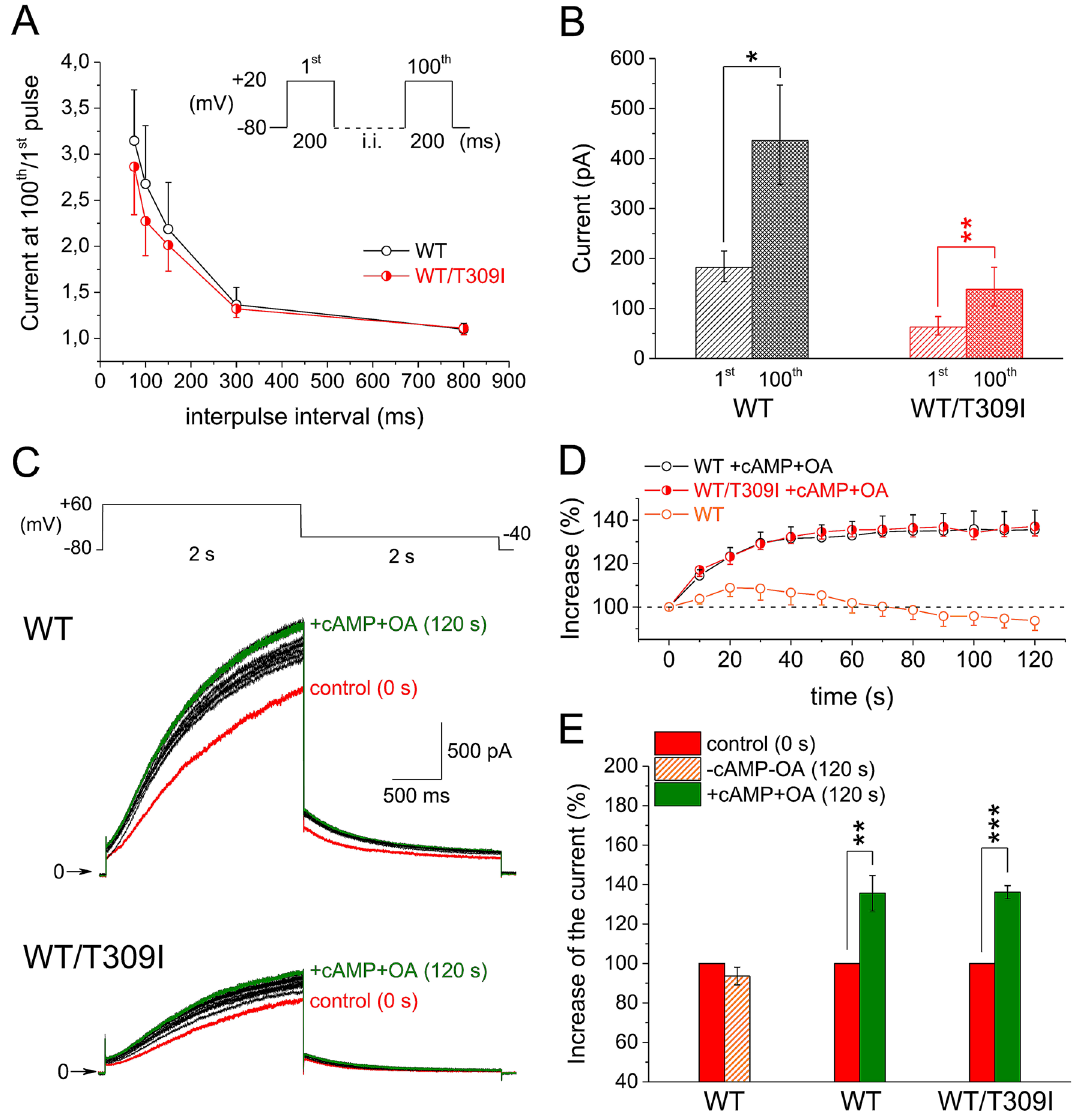
Figure 3. Accumulation of WT and WT/T309I currents (KCNE1 subunit cotransfected). ( A ) Average relative rate-dependent accumulation of the currents at interpulse intervals between 75 and 800 ms ( n = 10 and 8 in WT and WT/T309I channels, respectively); inset: experimental protocol applied after a 30-s pause; i.i.—interpulse interval. ( B ) Average absolute currents at the 1st and 100th pulse of the accumulation protocol with the interpulse interval of 100 ms. ( C ) Experimental protocol (the stimulation frequency 0.1 Hz), and representative traces of WT and WT/T309I currents under simulated β-adrenergic stimulation (cAMP and OA in the pipette solution); red trace—time 0, control (no cAMP/OA stimulation); green trace—time 120 s, steady-state β-adrenergic stimulation; black traces—time 10 to 110 s in 10-s intervals, development of β-adrenergic response. ( D ) Time course of the relative increase of the current in presence of cAMP and OA (+ cAMP + OA) in WT and WT/T309I channels ( n = 14 and 8; n = 9 in WT without cAMP and OA). ( E ) Relative steady-state increase of the current in + cAMP + OA; *, ** and ***statistical significance at P < 0.05, 0.01 and 0.001, respectively. All graphs were prepared using the software Origin, version 8.5.1.